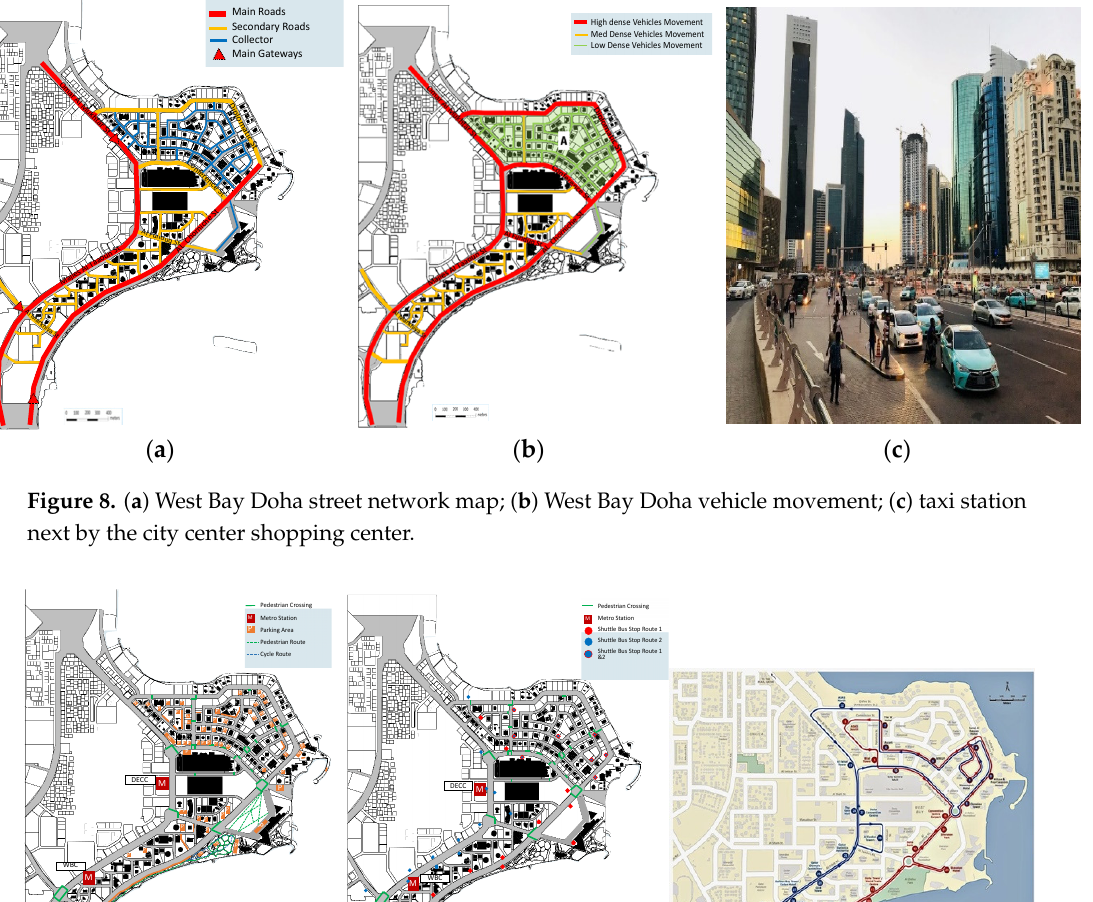
Figure 10. Corniche cycling network pattern. Table 2. The distance via transportation modes between West Bay Metro stations and nearby landmarks. WBC Station